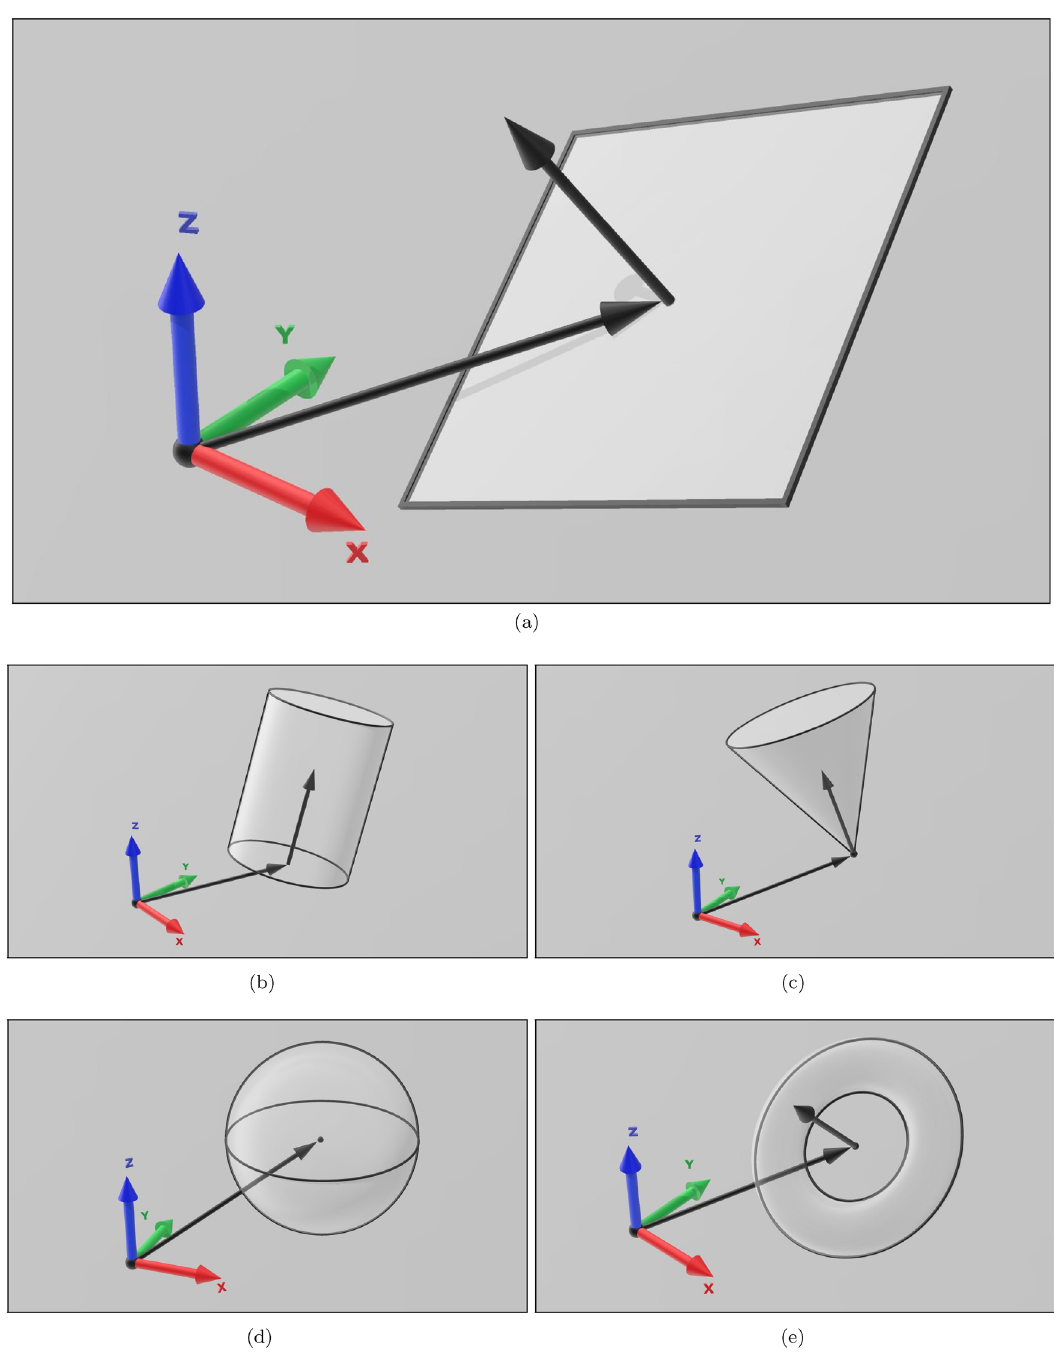
Figure 2: Shape features with position and orientation vectors. Spheres are not assigned an orientation due to three full degrees of freedom in rotation. ( a ) Plane with position and orientation vector. ( b ) Cylinder with position and orientation vector. ( c ) Cone with position and orientation vector. ( d ) Sphere with only position vector. ( e ) Torus with position and orientation